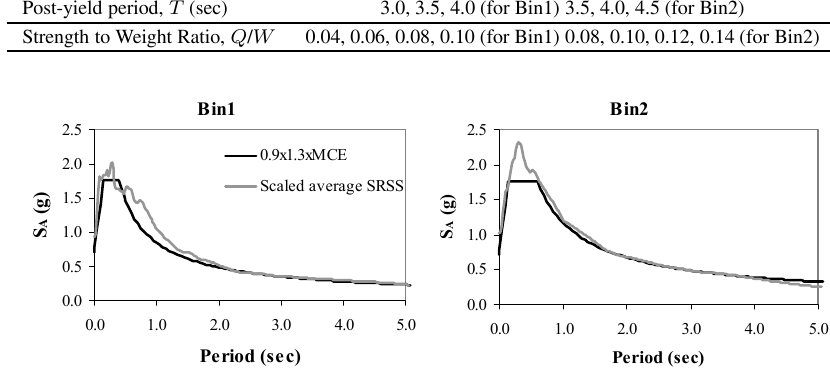
Fig. 2. Final scaling of ground motion records.